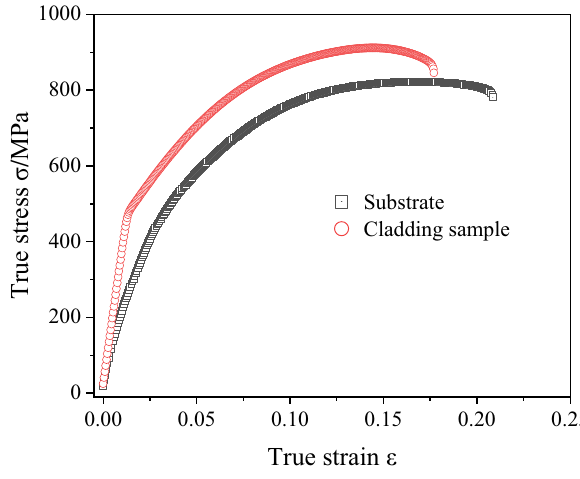
Figure 6: True stress – strain curves of SUB and cladding sample.